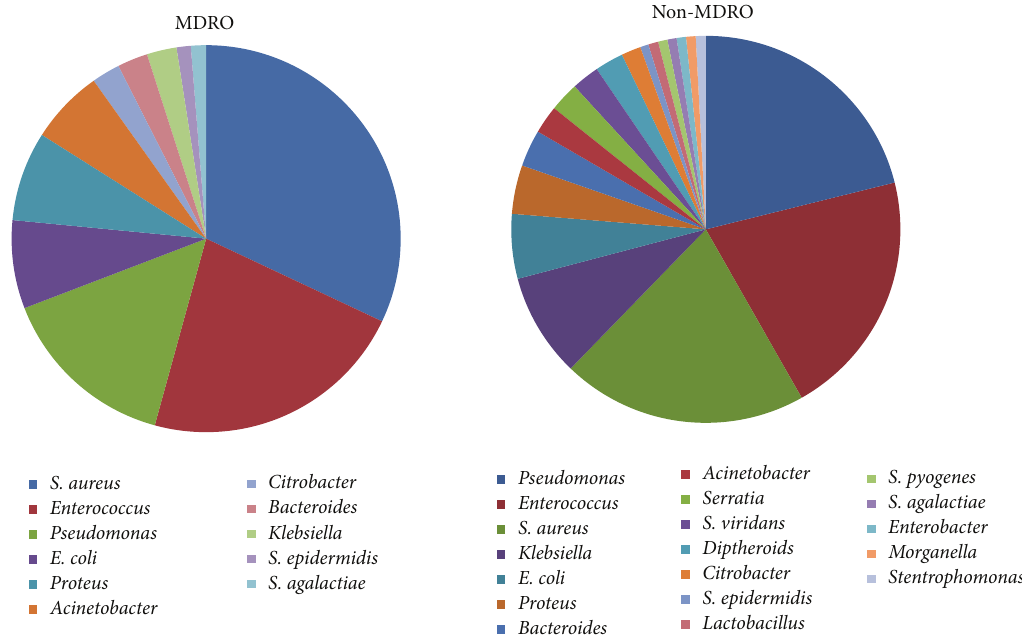
Figure 1: Overall prevalence of MDRO and non-MDRO isolated from